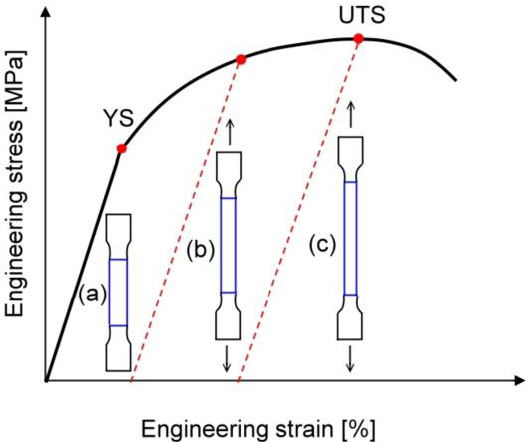
Figure 2. Experimental design philosophy for selection of plastic pre-strain levels applied to tensile test specimens in context of schematic engineering stress–strain diagram: ( a ) initial (unstrained) specimen, ( b ) plastically pre-strained specimen in tensile stress region between YS and UTS, and ( c ) plastically pre-strained specimen just at UTS.